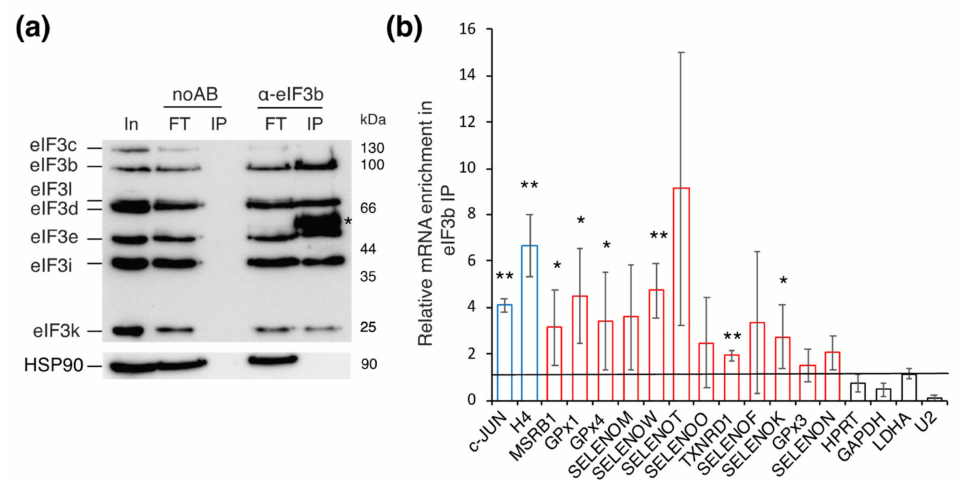
Figure 1. eIF3 interacts in vivo with selenoprotein mRNAs. Immunoprecipitation of the endogenous eIF3 complex and its associated RNAs from HEK293FT cells using antibodies against eIF3b ( α -eIF3b). ( a ) Analysis of the endogenous immunoprecipitated proteins by SDS-PAGE and Western blotting using antibodies against the indicated proteins. In: Input (5% of total); (FT): Flow through; (IP) immunopre- cipitation beads; noAB: control without antibodies. The position of the molecular weight markers is indicated. * Corresponds to the anti-eIF3b antibodies released from the immunoprecipitation beads and detected by the secondary antibodies by Western blotting ( b ) qRT-PCR analysis of eIF3-interacting mRNAs. The relative mRNA enrichment in the eIF3b IP was measured by qRT-PCR and determined by the ∆∆ Ct method using LDHA mRNA as a normalizer. c-JUN and histone H4 mRNAs (blue bars) are targets of eIF3 according to Lee et al., (2015) and Hayek et al., (2021) respectively. MSRB, GPX1- 4, TRXNRD1, and SELENO are mRNAs of selenoproteins (red bars). HPRT (hypoxanthine guanine phosphoribosyltransferase), GAPDH (glyceraldehyde-3-phopshate dehydrogenase), and LDHA